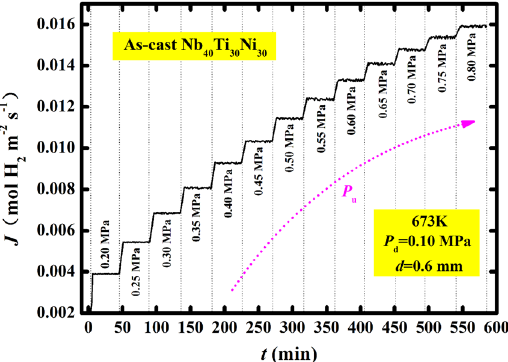
Figure 4. Measured hydrogen permeation flux ( J ’) as a function of time ( t ) at different upstream pressures ( P u ) at 673 K for the as-cast Nb 40 Ti 30 Ni 30 alloy membrane.